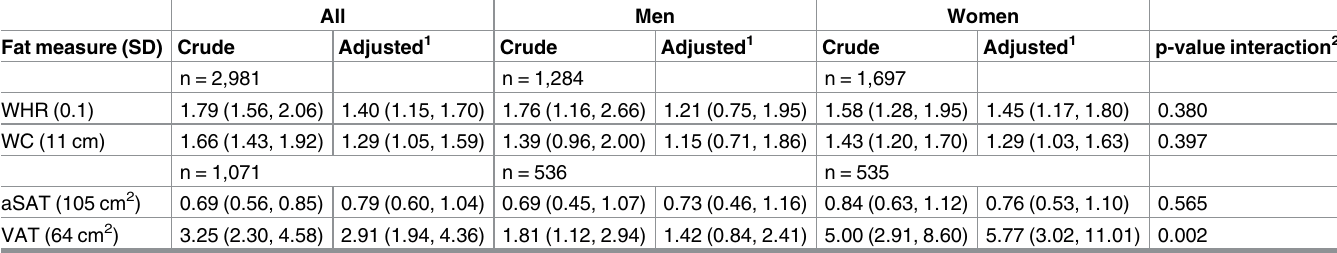
Table 2. Odds ratios per SD of measuresof body fat distribution on having at least one cardiometabolic risk factor. All